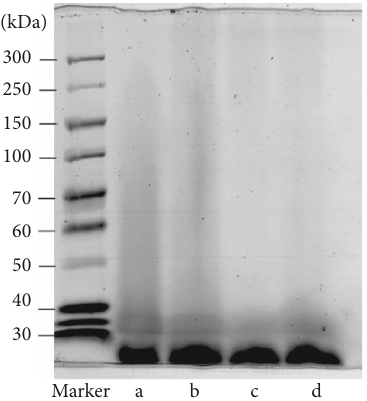
Figure 2: SDS-PAGE of the NCS sericin before and after being cross-linked with phytic acid. Samples a, b, and c represent the sericin cross-linked at pH 9.8, pH 7.4, and pH 4.1, respectively; Sample d was the uncross-linked